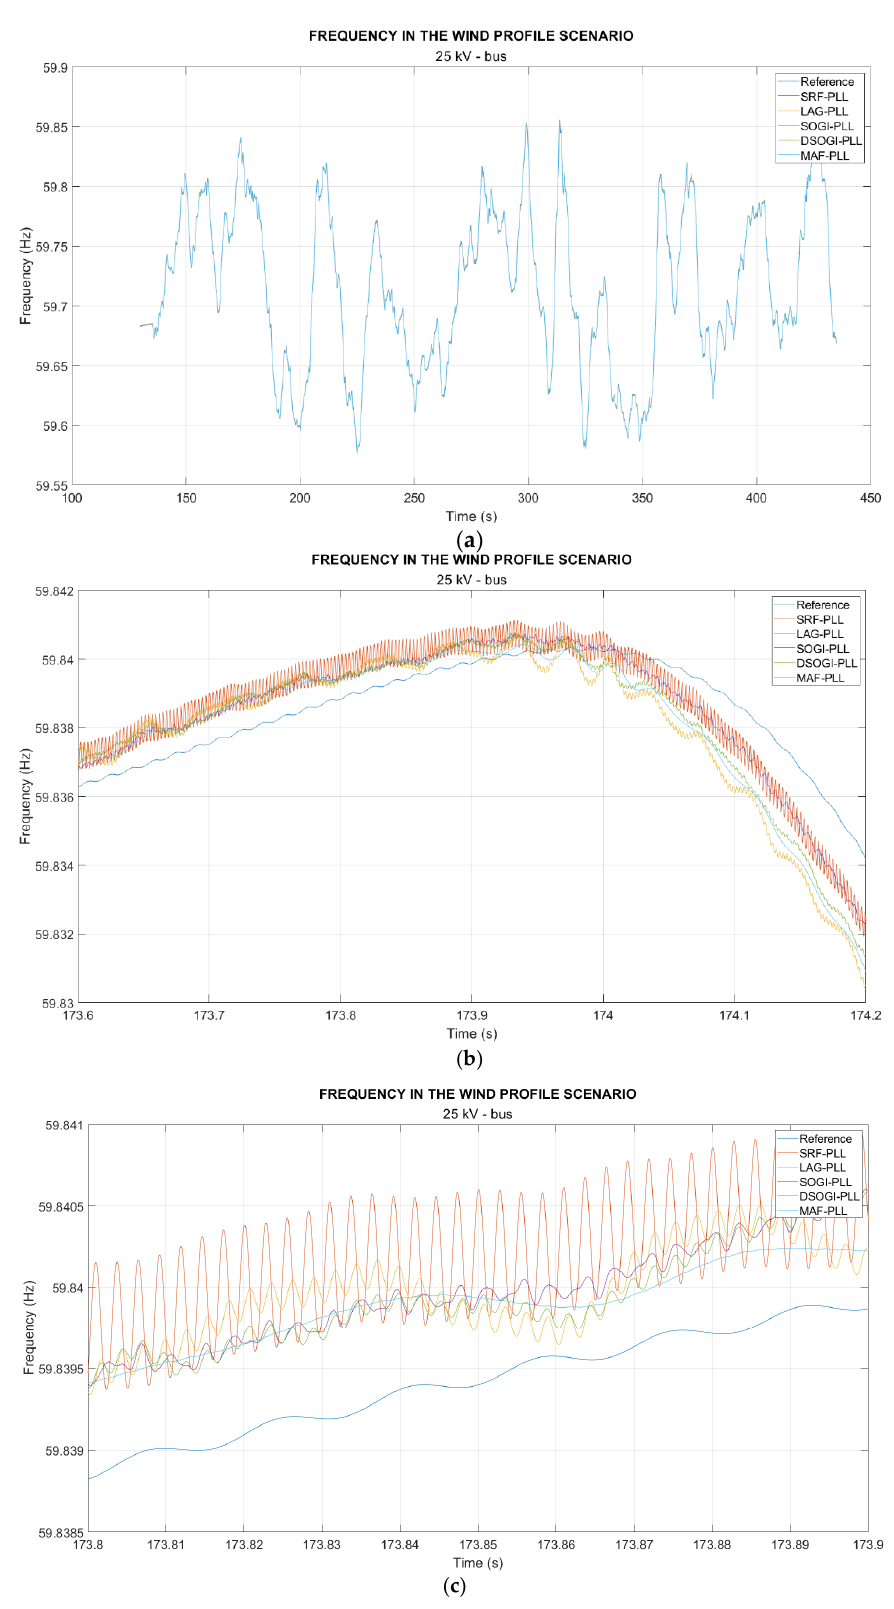
Figure 18. Frequency measurement with the PLLs located at the 25 kV WinGen bus in the variable wind speed scenario. The measurements are shown with different zoom levels: ( a ) from seconds 100 to 450, ( b ) from seconds 173.6 to 174.2, and ( c ) from seconds 173.8 to 173.9.